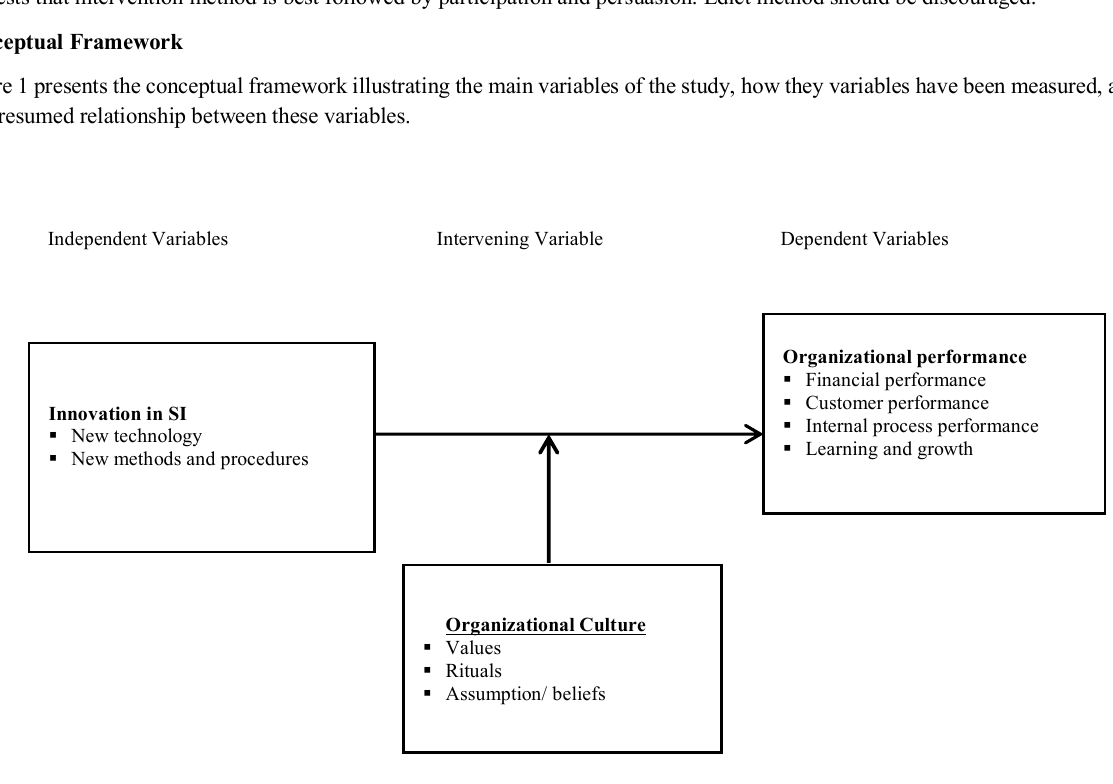
Figure 1: Influence of Strategy Implementation on